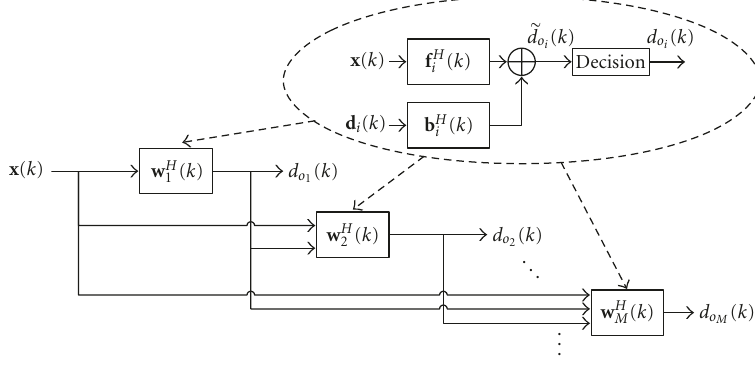
Figure 1: Adaptive BLAST MIMO decision feedback equalizer